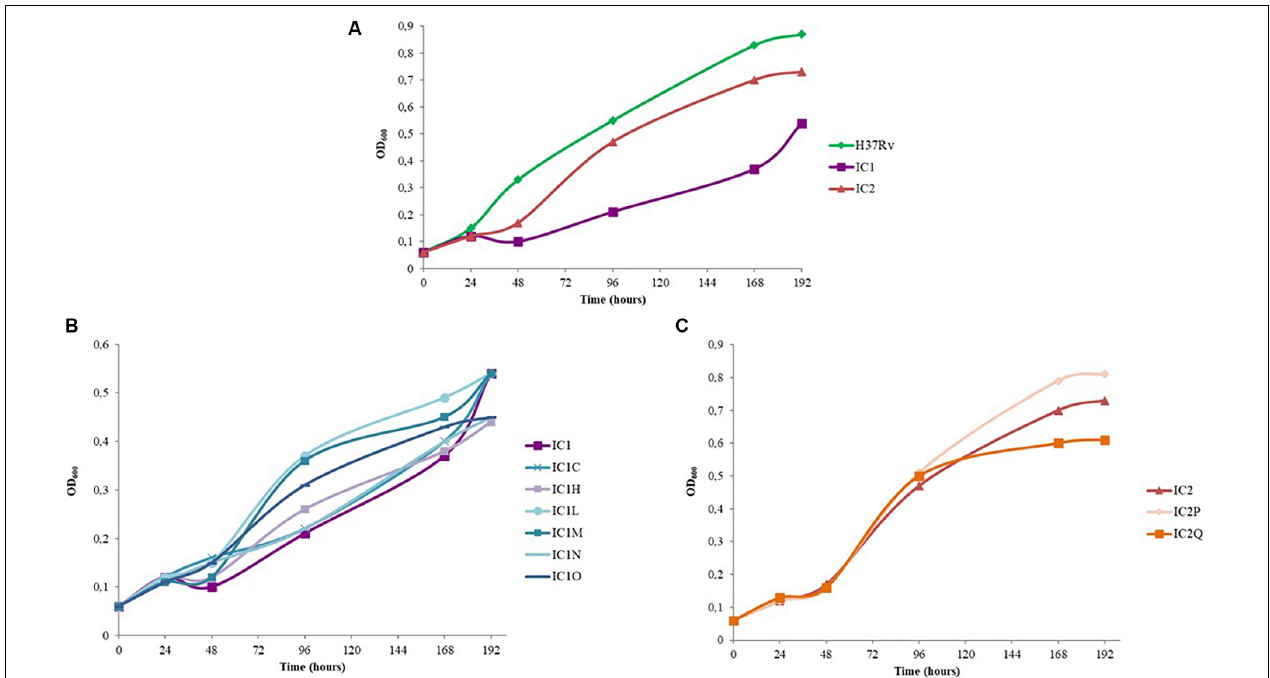
FIGURE 1 | Growth curves of standing cultures of M. tuberculosis strains (H37Rv, clinical isolates and mutant strains). The experiment was repeated three times giving comparable results. The figure shows one representative experiment. (A) Growth curves of M. tuberculosis H37Rv strain and IC1 and IC2 clinical isolates. (B) Growth curves of IC1 clinical isolate and the following BDQ resistant mutants: IC1 C (representative mutant strain with A63P mutation in AtpE), IC1 H, IC1 L, IC1 M, IC1 N, IC1 O. (C) Growth curves of IC2 clinical isolate and the BDQ resistant mutants IC2 P and IC2